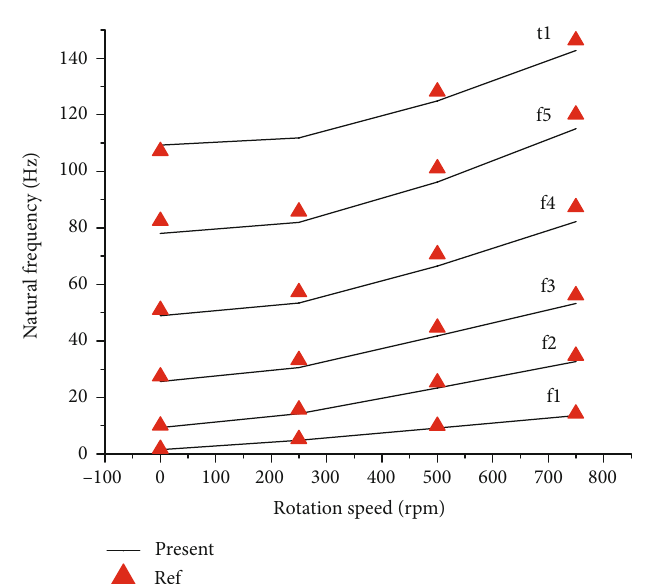
Figure 3: Meshing of the blade model.